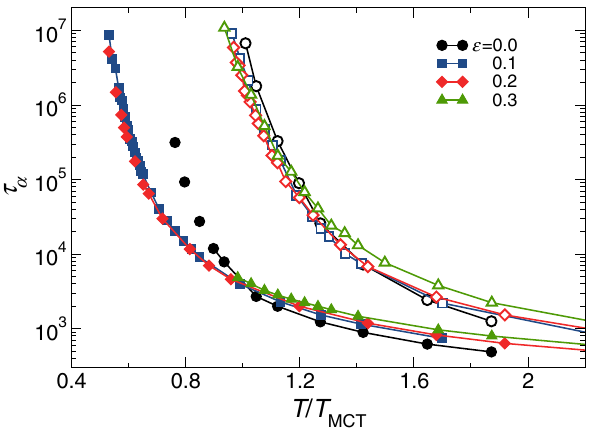
FIG. 9. Relaxation times for systems with continuous poly- dispersity, n ¼ 12 , and different nonadditivity parameters ϵ . Temperatures are scaled by T to allow direct comparison MCT ¼ 0 . 267 , 0.176, 0.104, and 0.0534, between models, with T MCT respectively. Open symbols represent the standard Monte Carlo dynamics, and closed symbols show the swap algorithm, for which unconnected symbols represent structurally unstable state points where only a rough estimate of τ α is obtained in short simulations. A well-chosen amount of nonadditivity, ϵ ≈ 0 . 1 – 0 . 2 , considerably improves the efficiency of thermalization and the structural